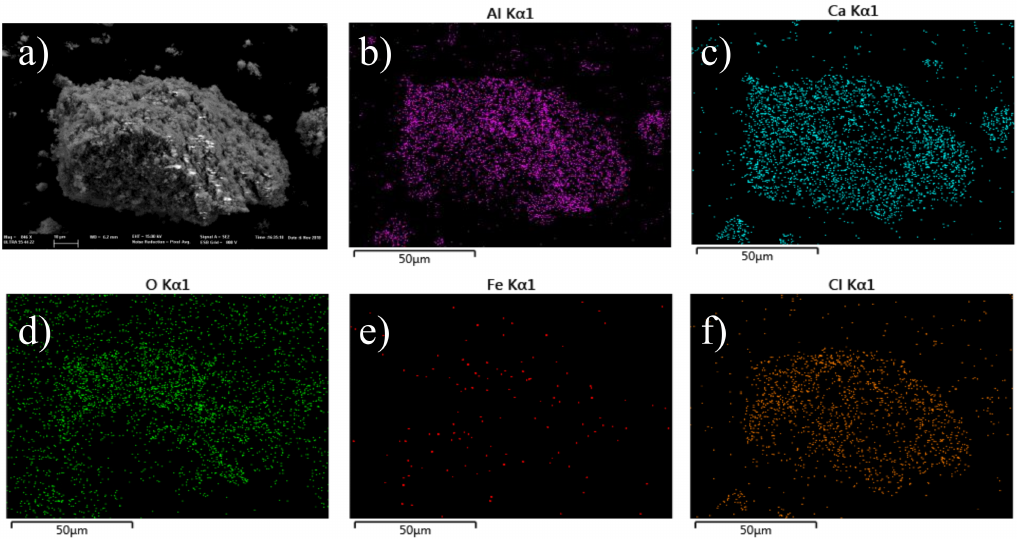
Figure 6. ( a ) FESEM micrograph (magnification of × 5500) of post-reaction Fe / mayenite; atomic mapping of post-reaction Fe / mayenite: ( b ) Al (purple); ( c ) O (green); ( d ) Ca (blue); ( e ) Fe (red); ( f ) Cl